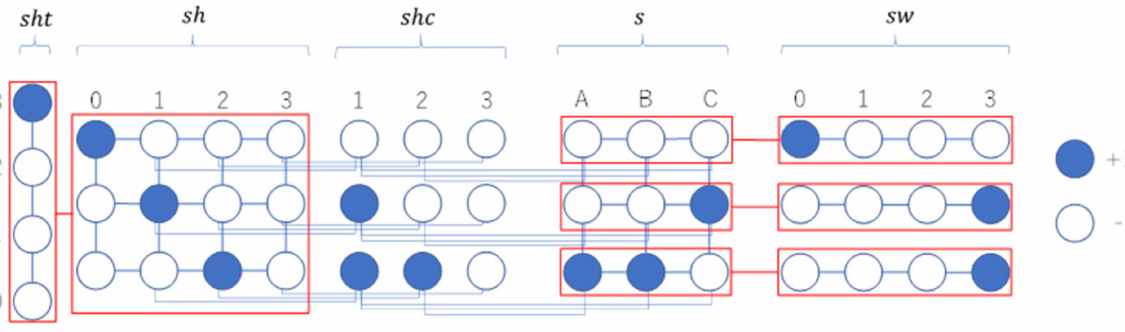
Figure 2. Relations of the spins (Figure